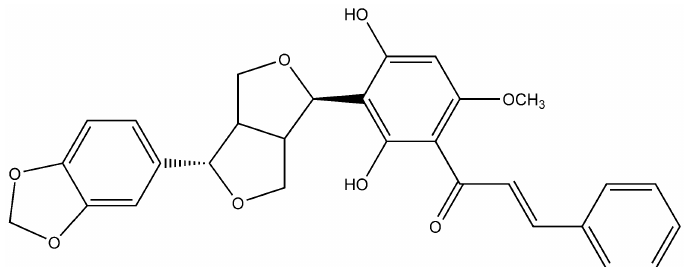
Figure 6. Lead compound of flavonolignan exhibiting antioxidant and antidiabetic activity.